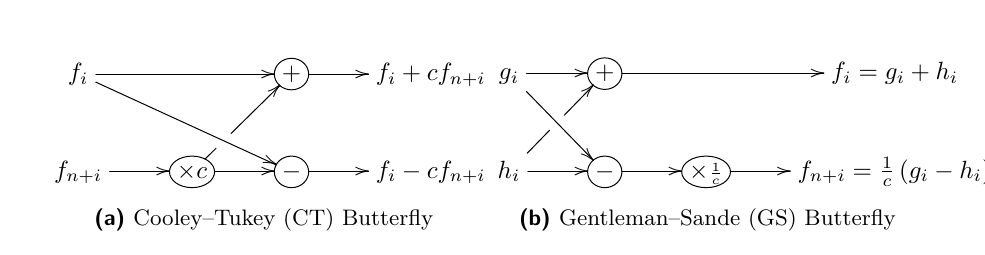
Figure 1: The “Butterflies” of Fast Fourier